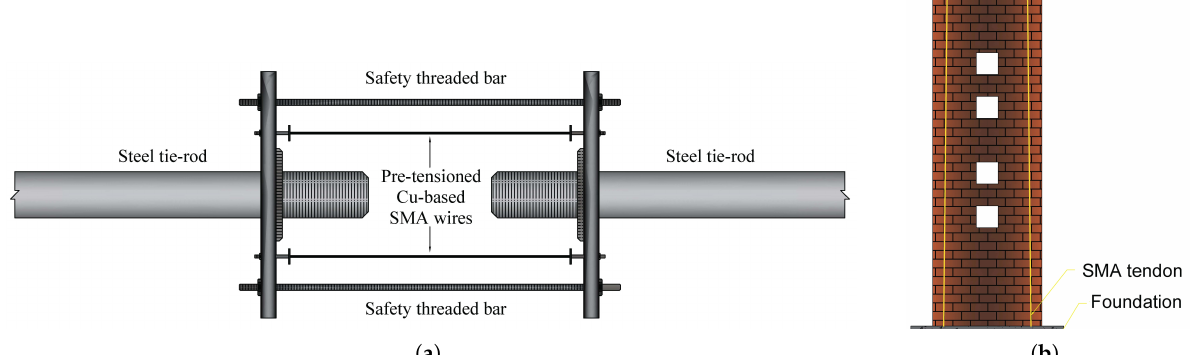
Figure 20. ( a ) Retrofitting scheme of the San Paolo Eremita church [76]; ( b ) installation of four pre-tensioned steel tie bars and SMA devices in the interior corners of the S. Giorgio church bell tower that were anchored to the foundation and the roof [82] (figures are taken from